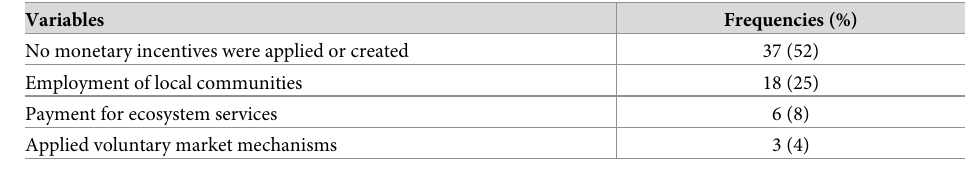
Table 3. Socio-economic results of